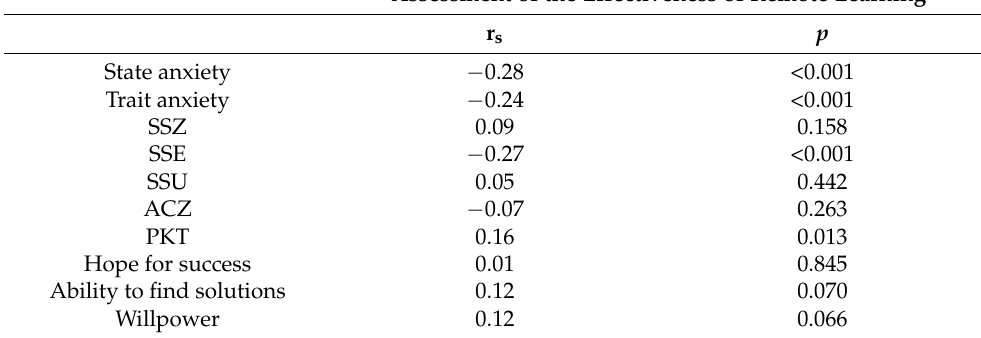
Table 3. Spearman’s correlations between the assessment of learning effectiveness and the level of anxiety, coping styles and hope for success. Assessment of the Effectiveness of Remote Learning r s p State anxiety − 0.28 <0.001 Trait anxiety − 0.24